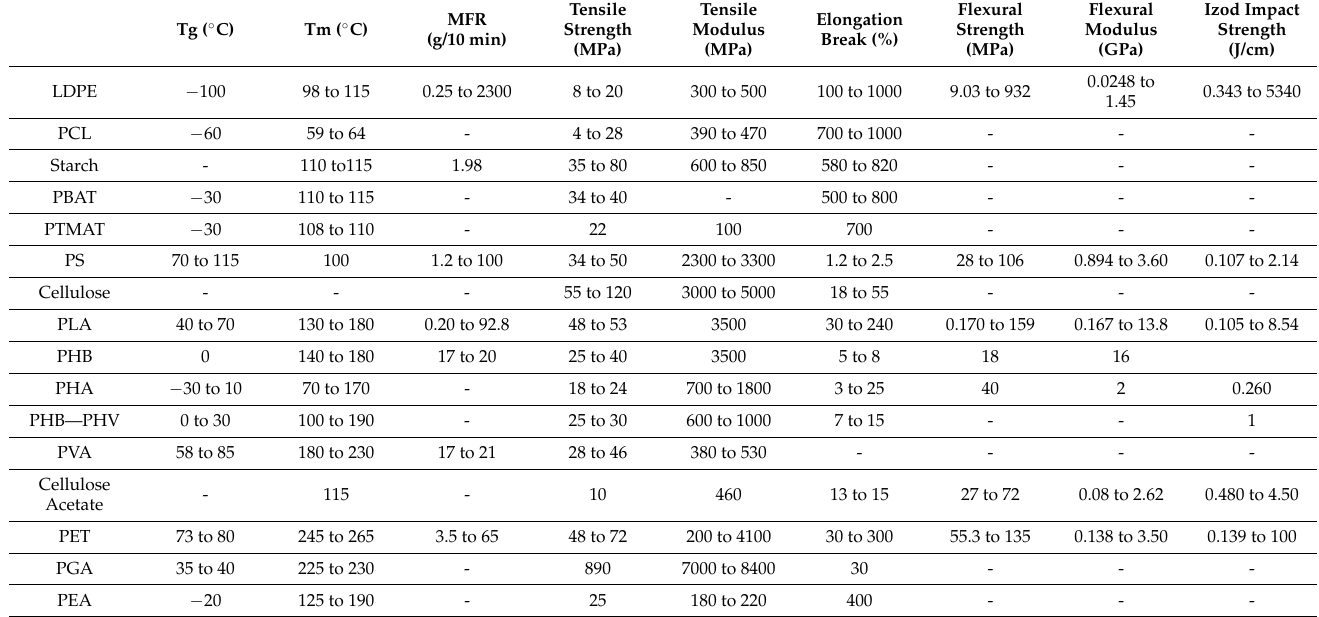
Table 1. Comparison of typical biodegradable polymer physical properties with LDPE, PS and PET.